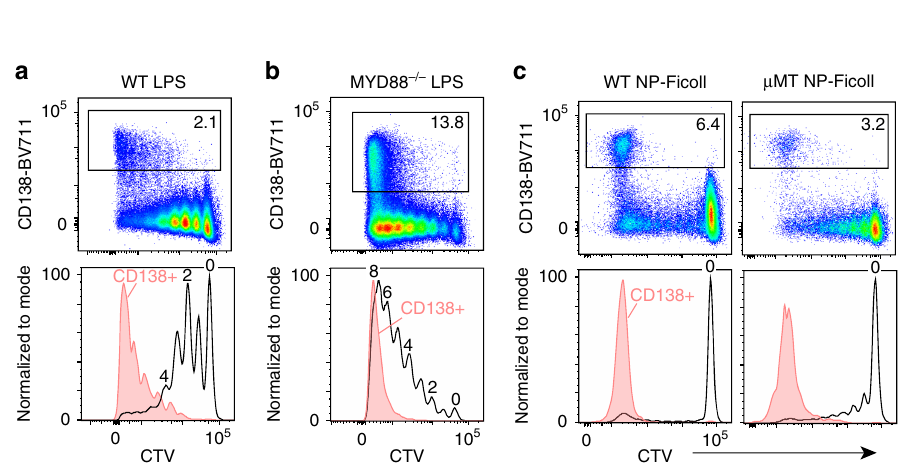
Fig. 1 Cell division mapping of ASC differentiation in vivo. a Representative fl ow cytometry plots of B220 versus CD138 (top), CD138 versus CTV (middle), and CTV histograms (bottom) at the indicated time points following in vivo LPS inoculation. The percentage of total CD138 + cells is indicated in the top row. b Frequency of CD138 + cells at each division at 72 h. c Frequency of CD138 + cells at each time point. d Representative fl ow cytometry of CD138 versus CTV plots 72 h after μ MT hosts were challenged with 50 μ g (black), 0.5 μ g (red), or 0.005 μ g (green) of LPS. e Frequency of transferred cells at each division for each dose. Red or green asterisk indicates signi fi cance of P < 0.0001 between 50 versus 0.5 μ g and 50 versus 0.005 μ g, respectively, unless otherwise stated. f The percentage of total CD138 + cells is shown for samples from ( e ). g The percentage of division 8 cells that are CD138 + is shown for samples from ( e ). h Representative images of total Ig ELISPOTs on cells sorted from division 1 – 5, 6, or 8 (CD138 – or CD138 + ) 72 h post LPS challenge from one mouse. i ELISPOTs from ( h ) were quantitated as the percentage of total cells plated that formed ASC. Data in ( a – c ) are representative of three independent experiments containing 24 h ( n = 5), 48 h ( n = 4), 54 h ( n = 4), 60 h ( n = 6), and 72 h ( n = 7) mice. Data in ( d – g ) were derived from three independent experiments with 50 μ g ( n = 9), 0.5 μ g ( n = 6), and 0.005 μ g ( n = 7) mice. Data in ( h – i ) were derived from two independent experiments from seven total mice. Data in ( b , c , e – g , i ) represent mean ± SD. Statistical signi fi cance in ( e ) was determined by a two-way ANOVA with Tukey ’ s post test for multiple comparisons. Statistical signi fi cance for ( c , f , g , i ) was determined by one-way ANOVA with Tukey ’ s post test for multiple comparisons. Source data are provided as a Source Data fi le.